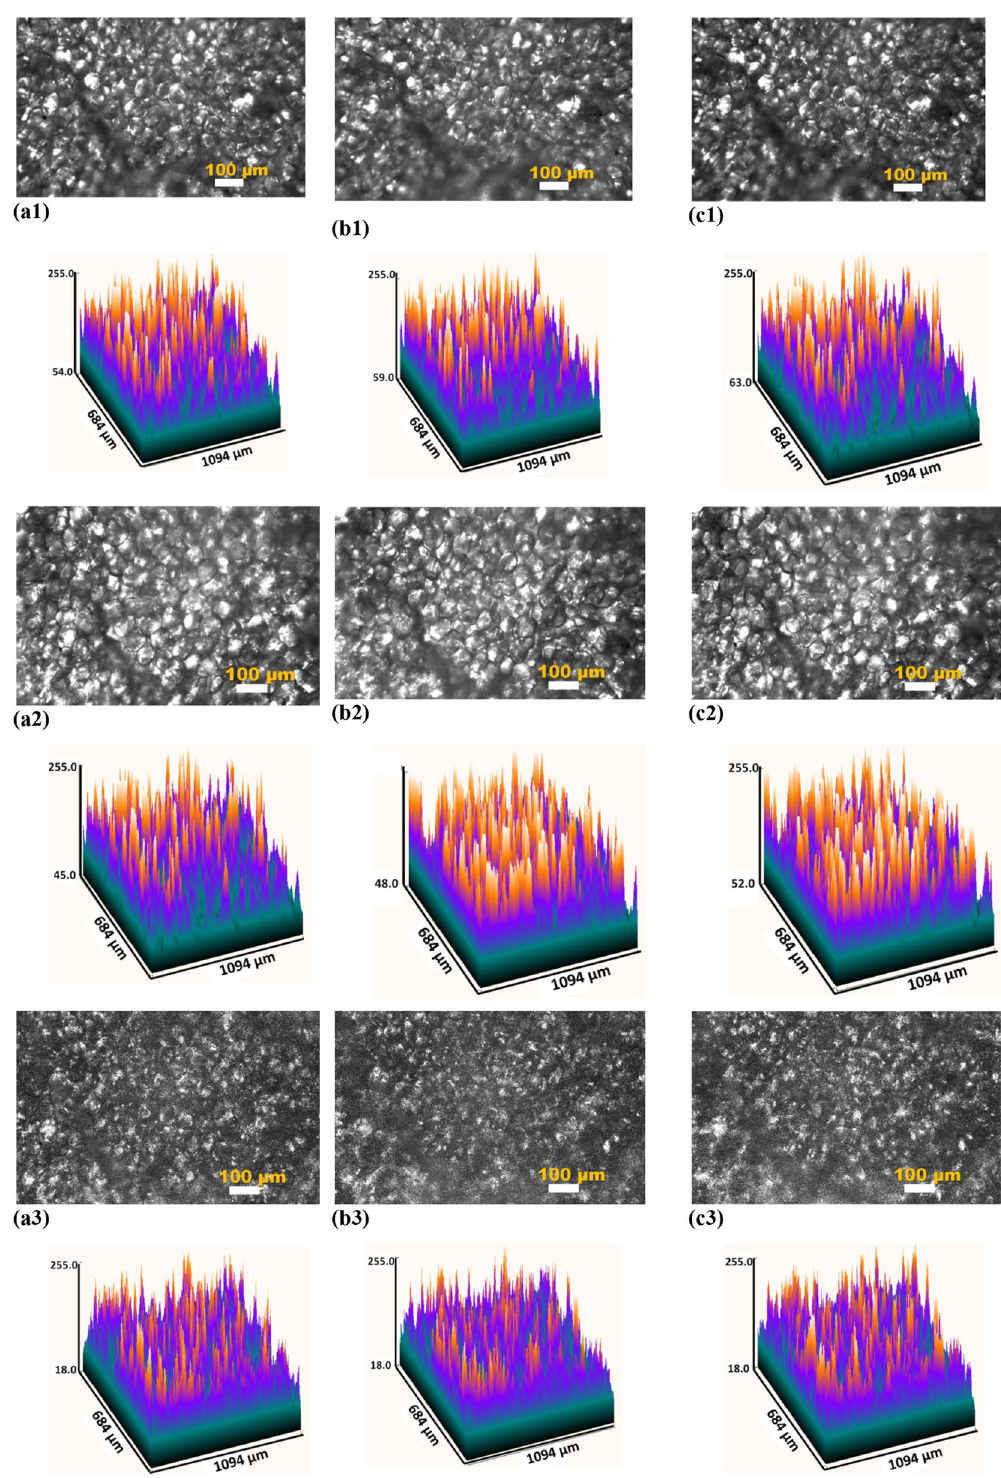
Figure 8. In vivo transmission images of rat abdominal AT sites (cell layer thickness is of 120 ± 15 μm) in the initial state at room temperature (25 °C) ( a ) and after heating up to 30 °C ( b ) and 38 °C ( c ). These images were obtained using the CS235MU monochrome CMOS camera KiraluxTM, the number of pixels in the matrix of 1280 × 1024; 10 bits/pixel (Thorlabs Inc., Newton, New Jersey) with custom software ThorCam 5.6 (Thorlabs Inc., Newton, New Jersey), microscopic objective (lens 10 ×), and white light ( a1 , b1 , c1 ), green LED with the wavelength of 517 nm( a2 , b2 , c2 ), light of He–Ne laser (632.8 nm) ( a3 , b3 , c3 ). The corresponding 2D distributions of image brigtness were built using ImageJ. In vivo back reflectance images of rat abdominal AT (cell layer thickness is of 100 ± 15 μm) in the initial state ( a4 ) and after hot saline solution (50 °C) application ( b4 ); the initial state ( a5 ) and after compression with a fiber tip ( b5 ); image of another rat abdominal AT in the initial state ( a6 ) and after applying the immersion optical clearing agent PEG-300 ( b6 ) (the corresponding video are presented in Supporting Information). These images were obtained using the Basler A602f. monochrome CMOS camera (the number of pixels in the matrix of 656 × 491; 8 bits/pixel) with custom software made with National Instruments LabVIEW 8.5, microscopic objective (lens 10 × ), and green LED with the wavelength of 517